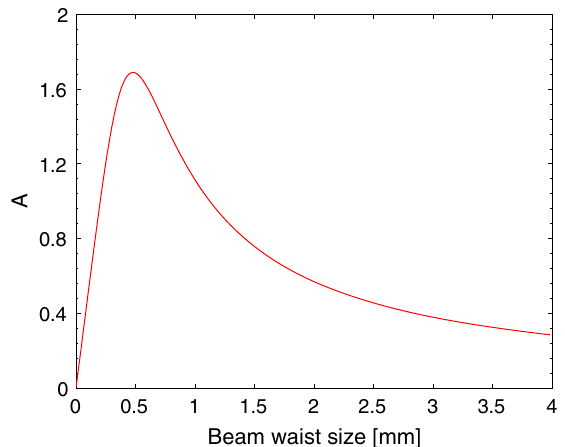
FIG. 3. Energy modulation strength with respect to different laser beam